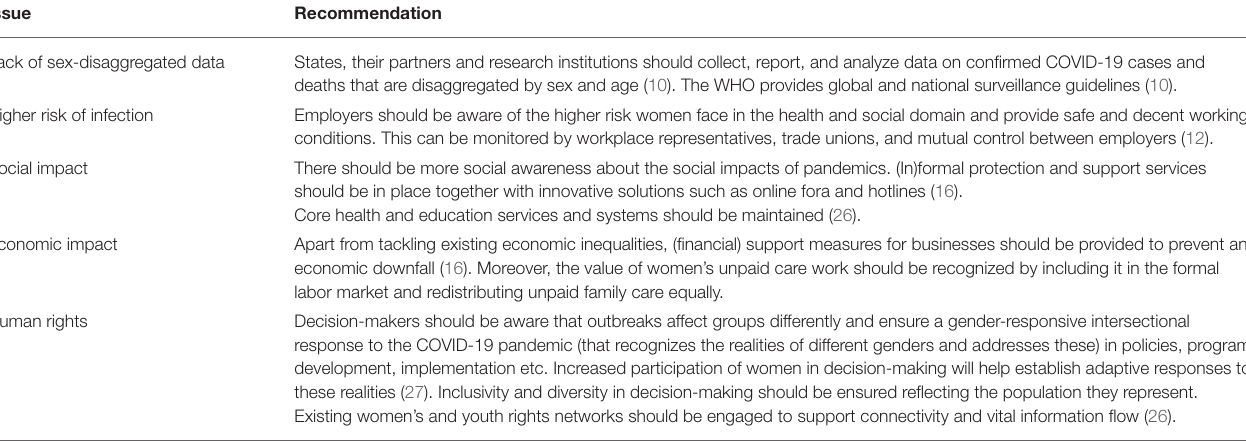
TABLE 1 | Recommendations for a more gender-sensitive approach to